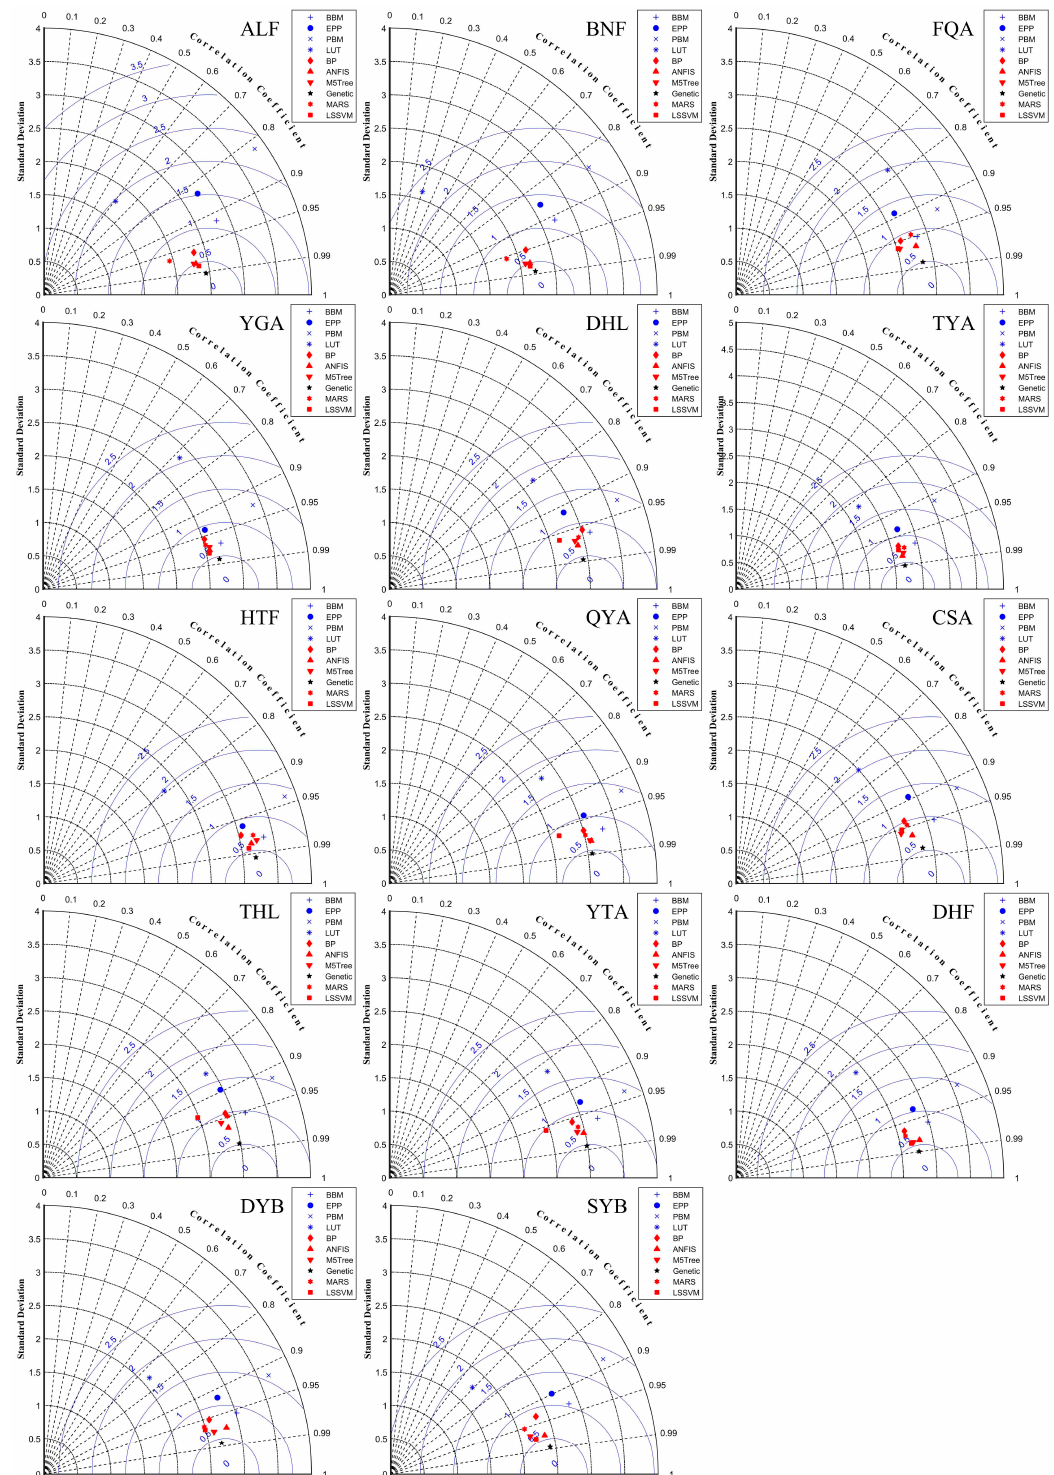
Figure 9. The statistical indicators representing the model accuracy in different stations.